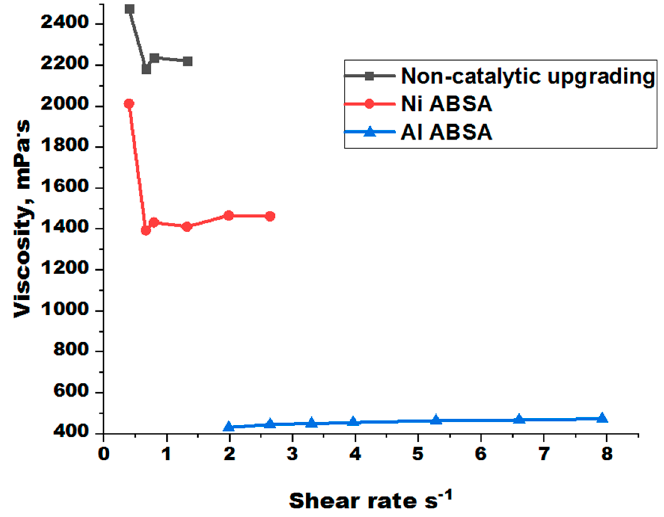
Figure 6. The dynamic viscosity of heavy-oil samples at 20 ◦